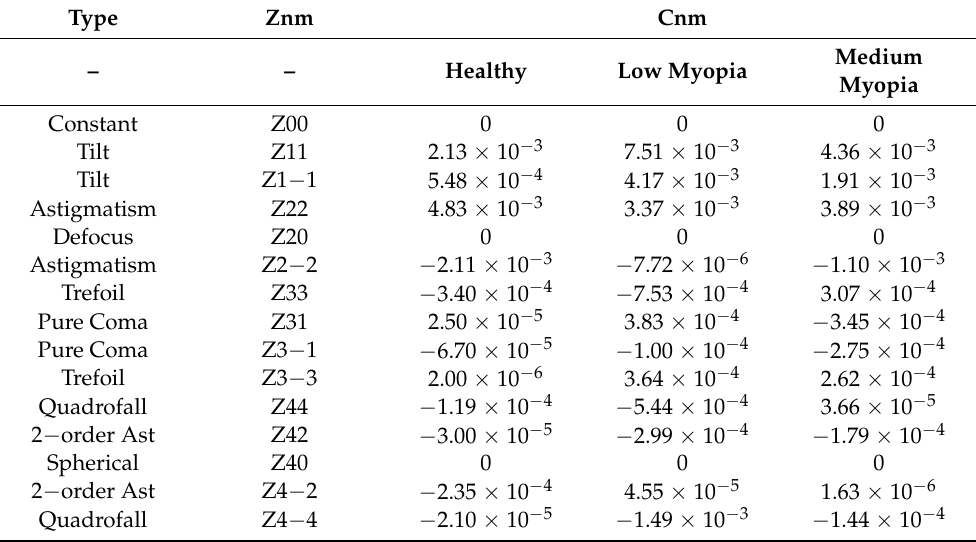
Table A2. Average Values of the Sum of the Zernike Weight Coefficients Anterior and Posterior Surfaces of the Cornea (Excluding Z n